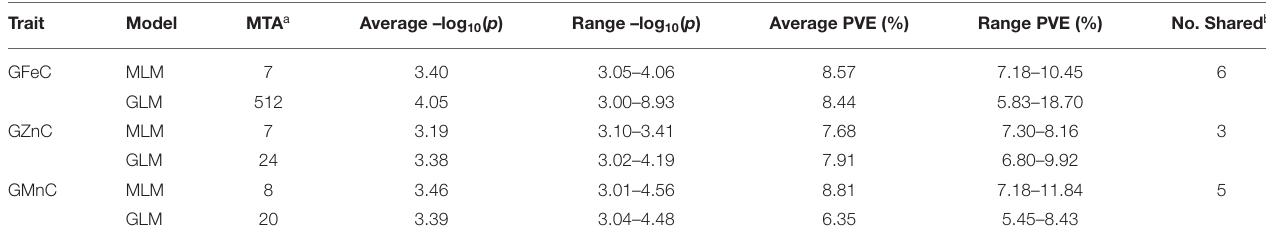
TABLE 3 | Significant MTAs identified by GWAS using GLM and MLM model.